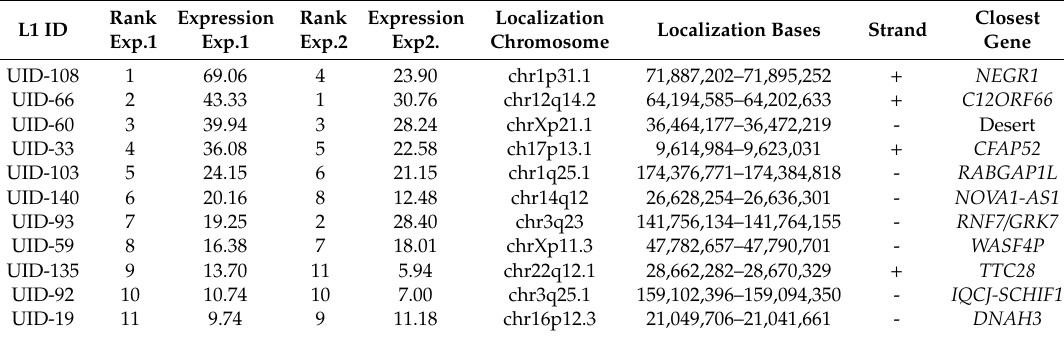
Table 1. Top L1 elements identified by